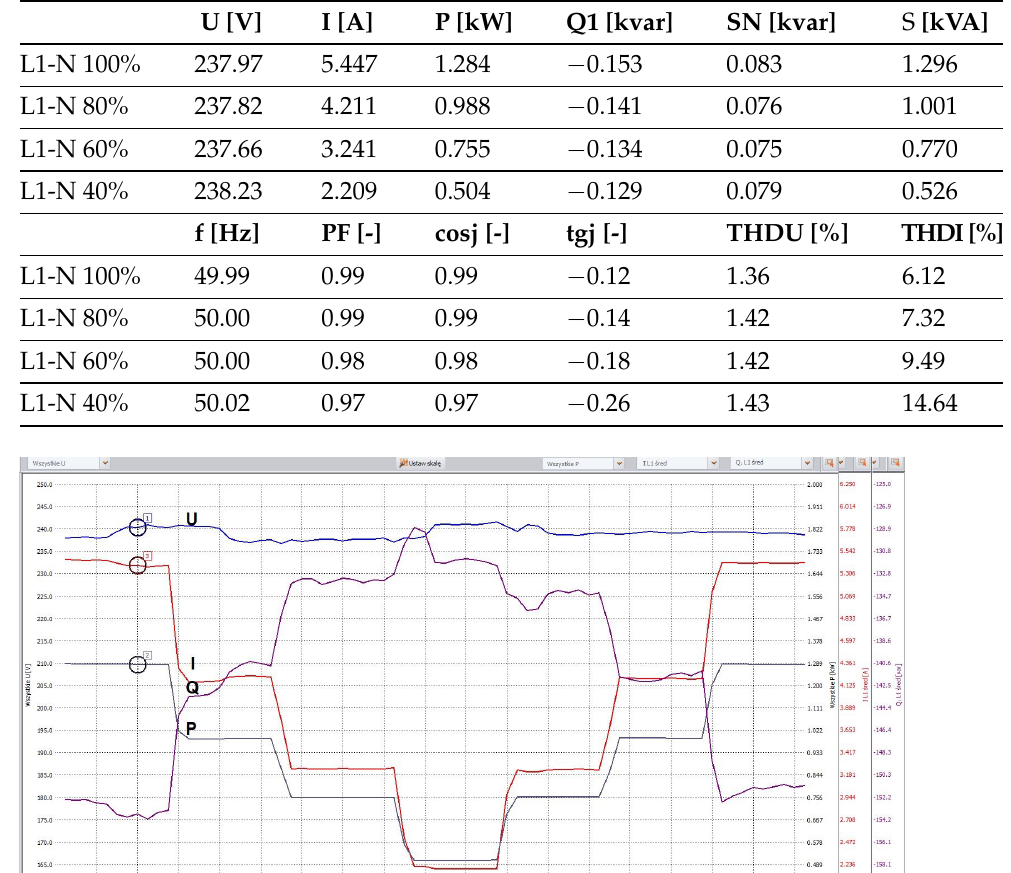
Table 3. Selected results of measurements of electrical parameters of a single-phase lighting installation.